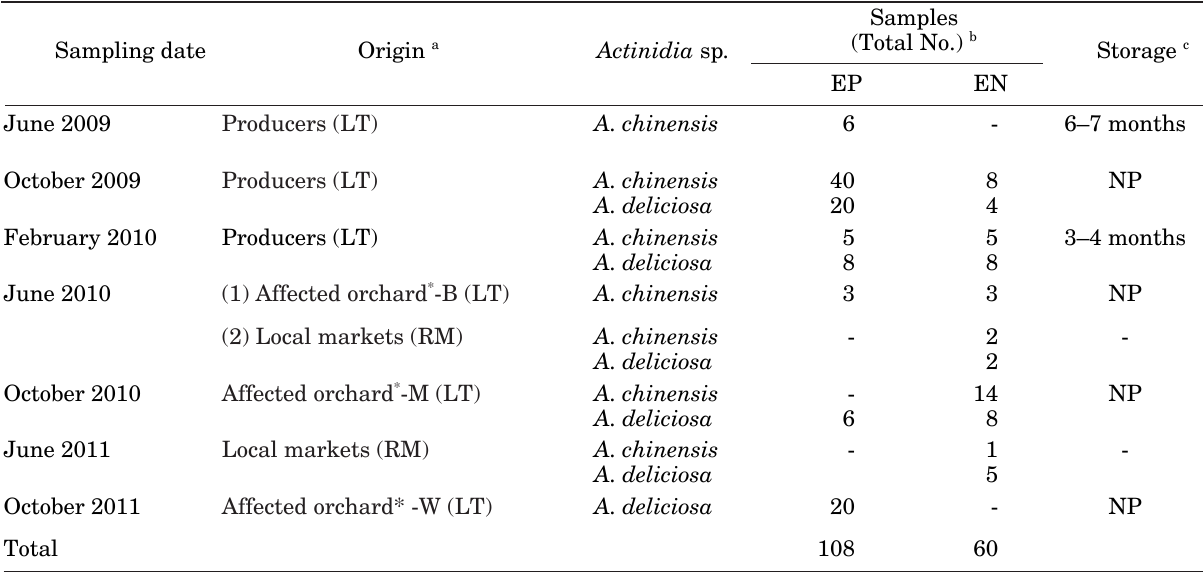
Table 1. Lists of fruit samples: their sampling date, origin, total number of tested samples, storage conditions and Actinidia species.